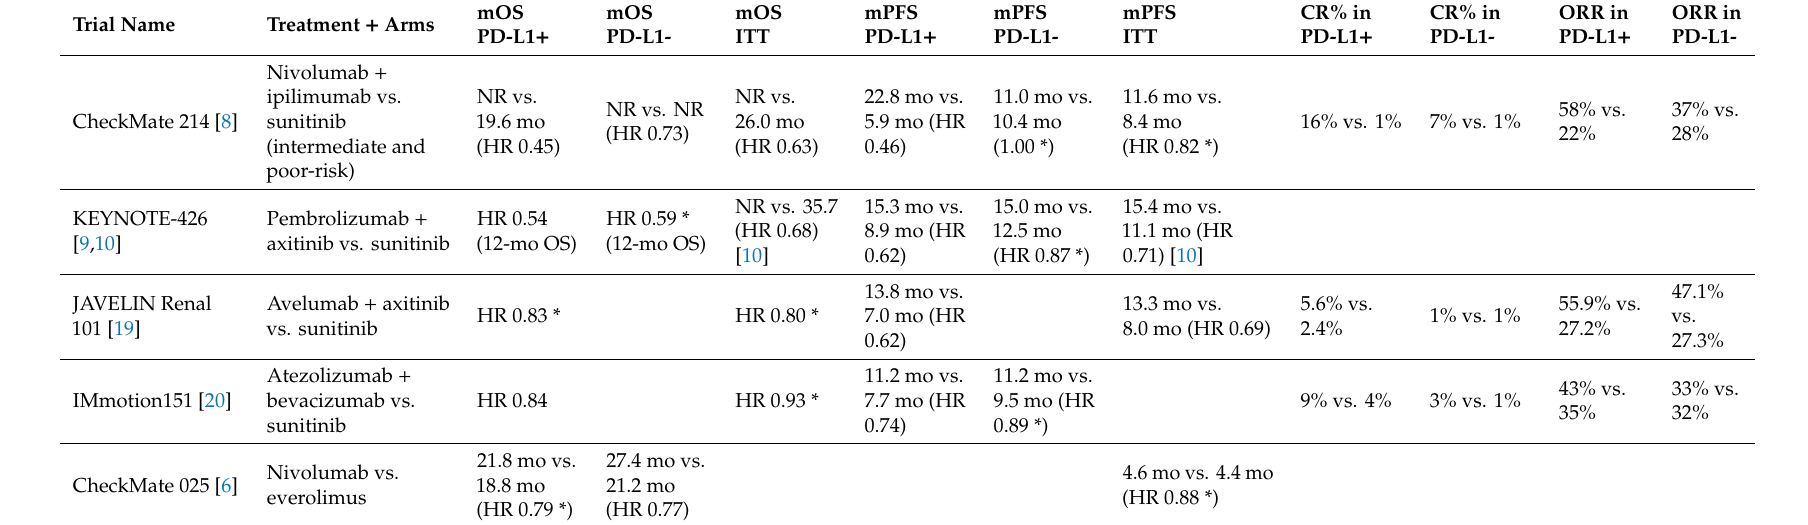
Table 1. Clinical outcomes by PD-L1 expression status from phase III clinical trials of immunotherapy in